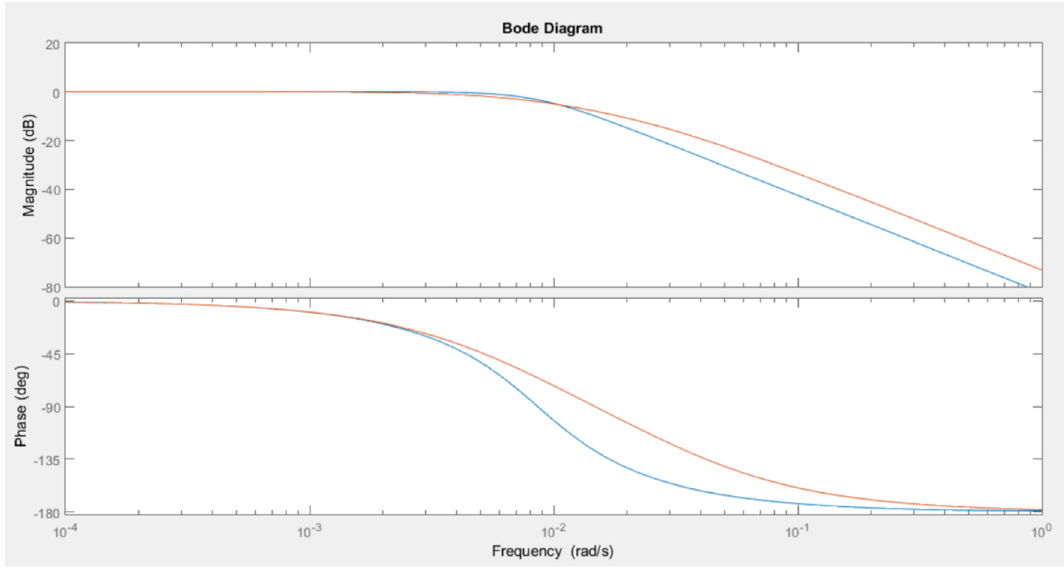
Figure 1. Length = 50 km, diameter = 0.7 m, mass flow = 60 kg/s, T ∈ (0.5 h; 24 h). (b) For L = 50 km, D = 0.7 m, and mass flow = 120 kg/s: